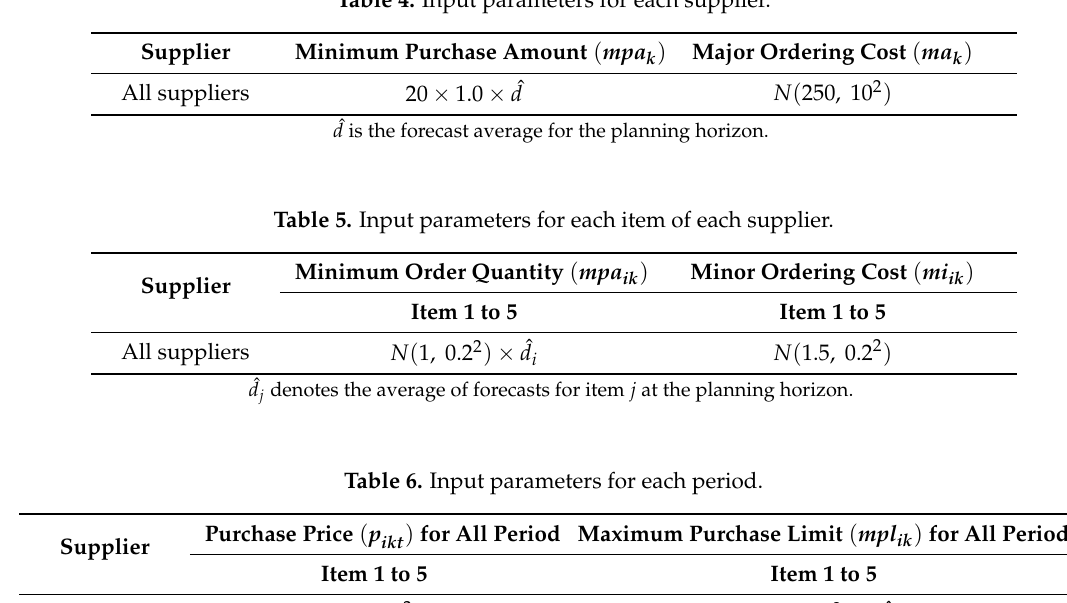
Table 4. Input parameters for each supplier.